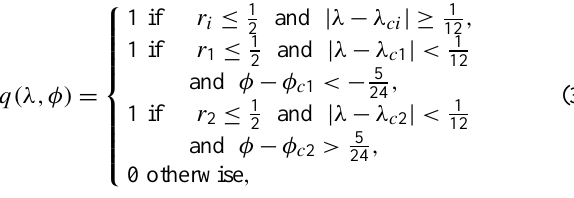
the test will show whether the characteristics of the numerical scheme are